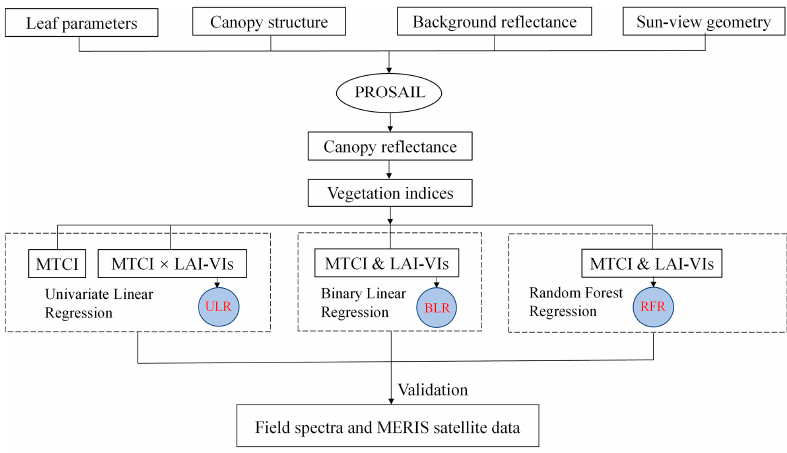
Figure 3. Flowchart of the VI combination approach for CCC retrieval.